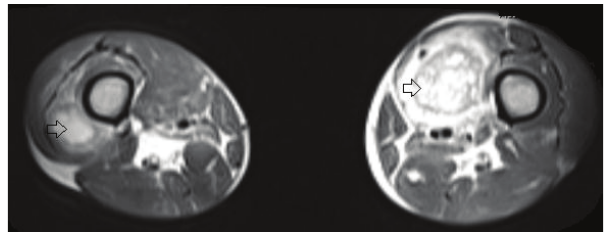
Figure 2: MRI of bilateral thighs showing contrast-enhancing metastatic skeletal lesions